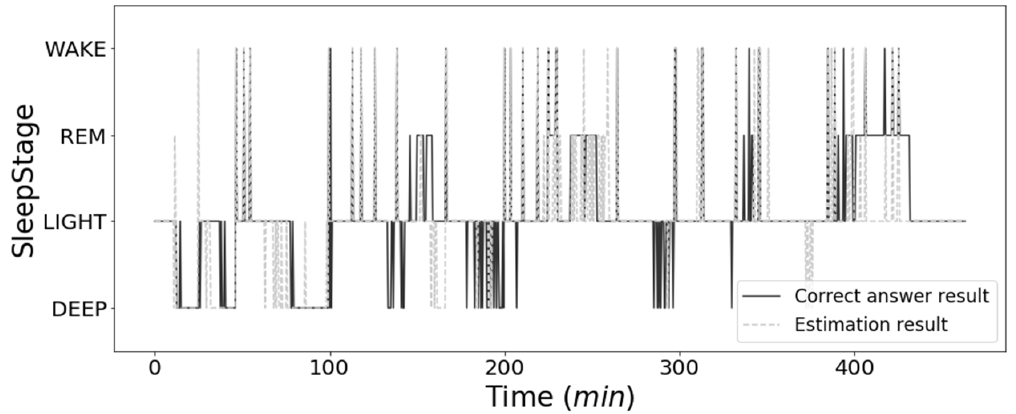
Figure 10. One subject’s overnight estimated results.